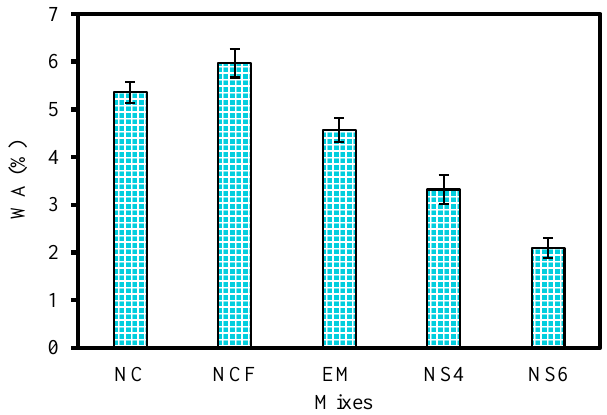
Figure 12. Water absorption rate at 28 days.